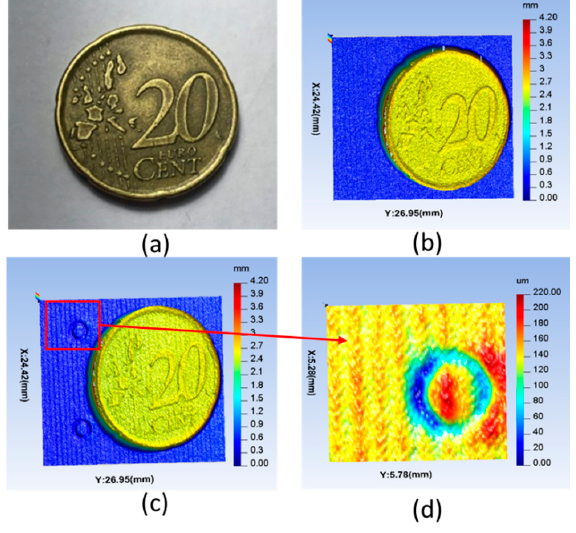
Figure 12. A twenty-cent coin and 3D reconstruction results: ( a ) photograph of the coin; ( b ) 3D measurement results of the coin after corrections; ( c ) 3D measurement results of the coin before corrections; ( d ) zoom in the error.